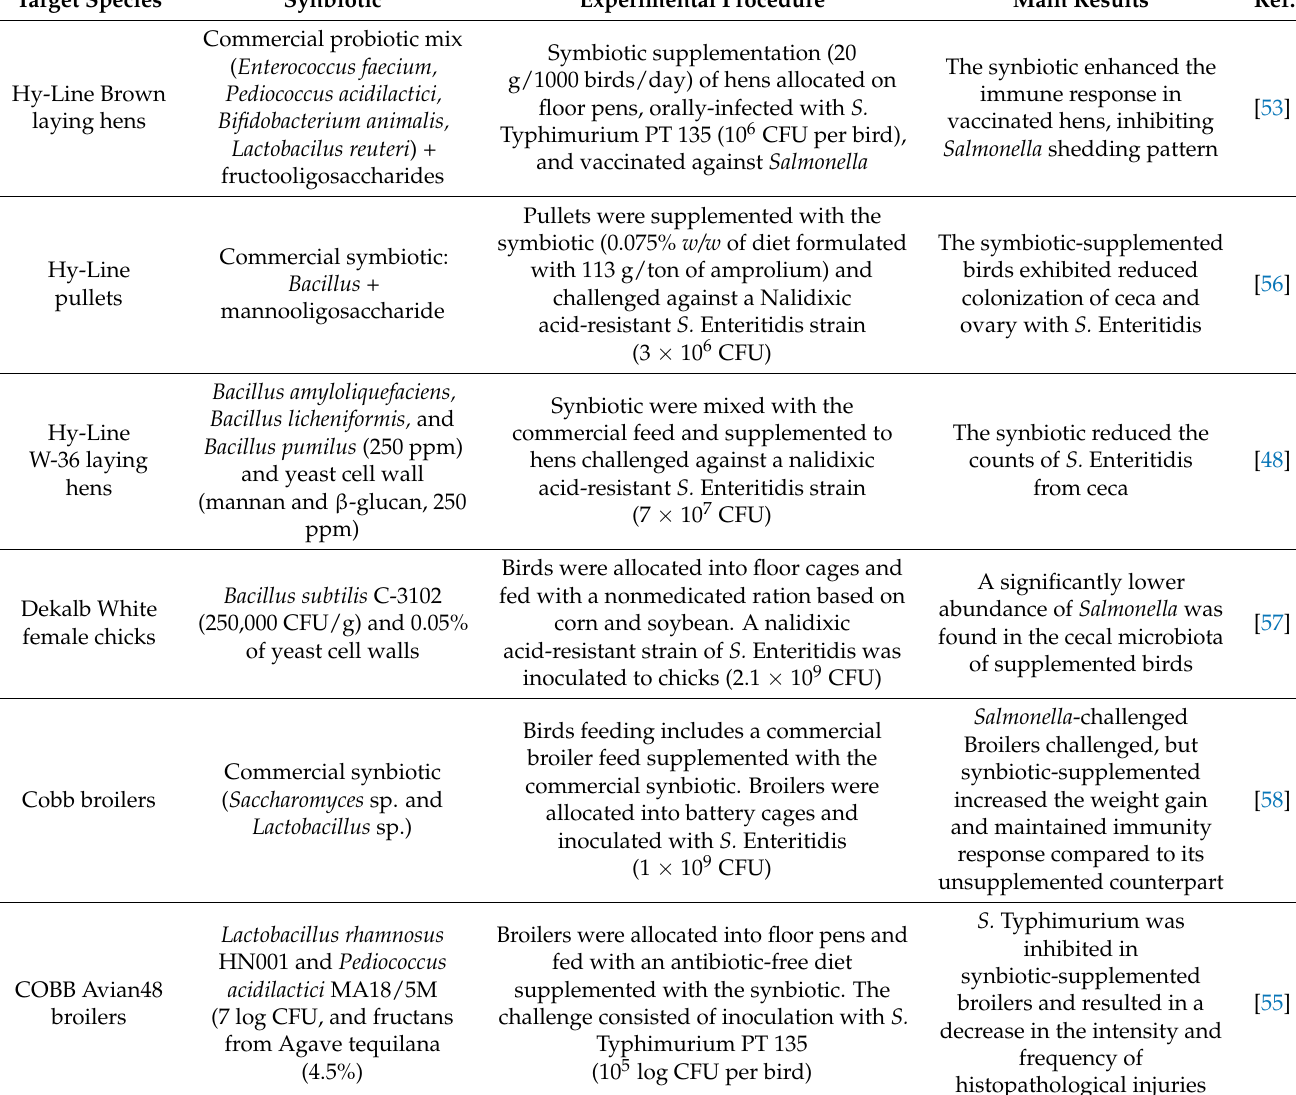
Table 3. Effects of dietary supplementation of synbiotics as a strategy to control Salmonella in